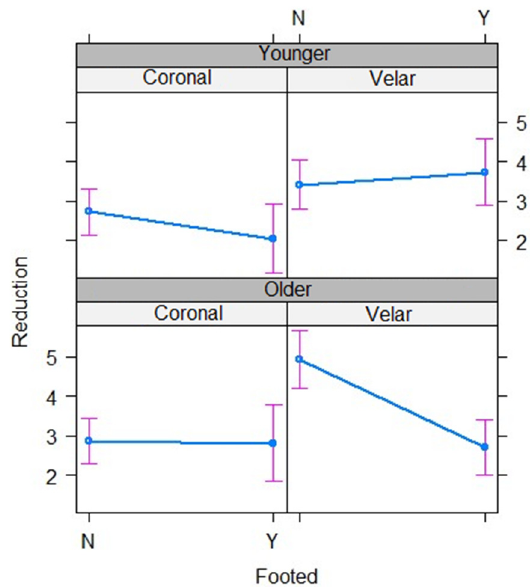
Figure 13. Effects plot of the three-way AgeGroup*Footedness*PlaceofArticulation effect. A higher reduction value indicates a greater tendency to reduce the past tense suffix. The plot shows the clear trend for Older speakers to reduce when the suffix is Not footed AND the nasal consonant is velar. The younger speakers show a tendency to reduce more with velar consonants in general and little difference according to footedness.